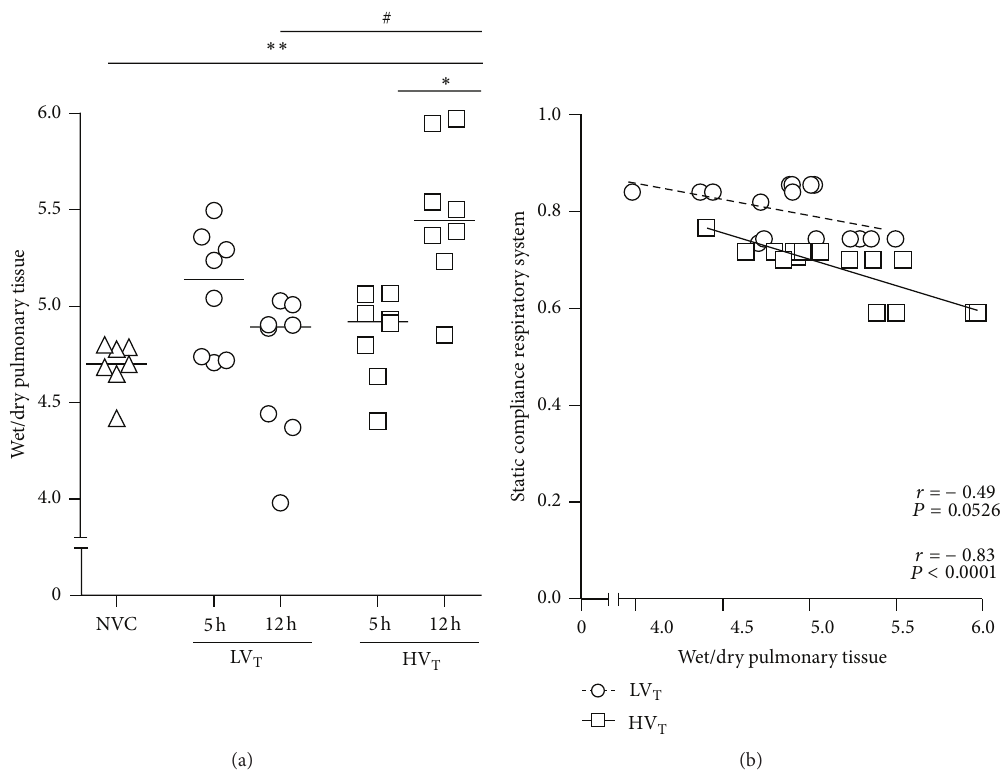
Figure 3: Edema formation. (a): Edema formation is represented by wet to dry ratios of lung tissue (Wet/Dry). Data are presented as scatter plot (median) of 7-8 mice per group (triangle = NVC; circle = LV T ; square = HV T ). ∗ Illustrates primary statistical analysis ( ∗ 𝑃 < 0.05 , ∗∗ 𝑃 < 0.01 ); # illustrates secondary statistical analysis ( # 𝑃 < 0.05 ). (b) In LV T /PEEP and HV T /ZEEP-ventilated mice, correlation analyses were performed between static compliance of respiratory system and wet/dry of pulmonary tissue. Linear correlations, Pearson correlation coefficients ( r ), and 𝑃 values are depicted. NVC = nonventilated controls; LV T , HV T = LV T /PEEP or HV T /ZEEP ventilator settings; 5h, 12h = 5 or 12 hours of